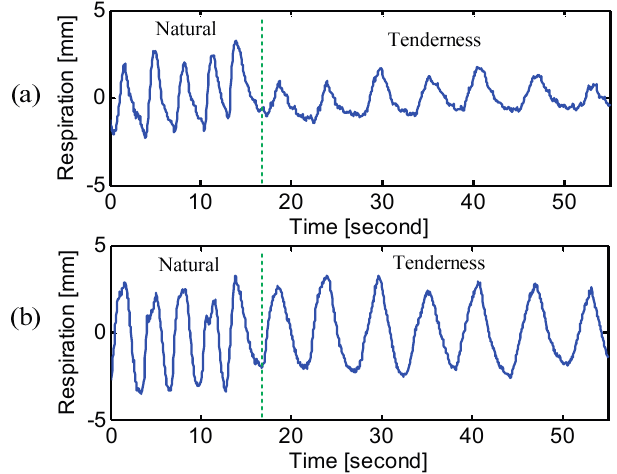
Figure 11. Radar measured respiration patterns of “anger” at ( a ) chest and ( b ) abdomen. The dashed line indicates the transition from natural breathing to the emotional state of “anger”.